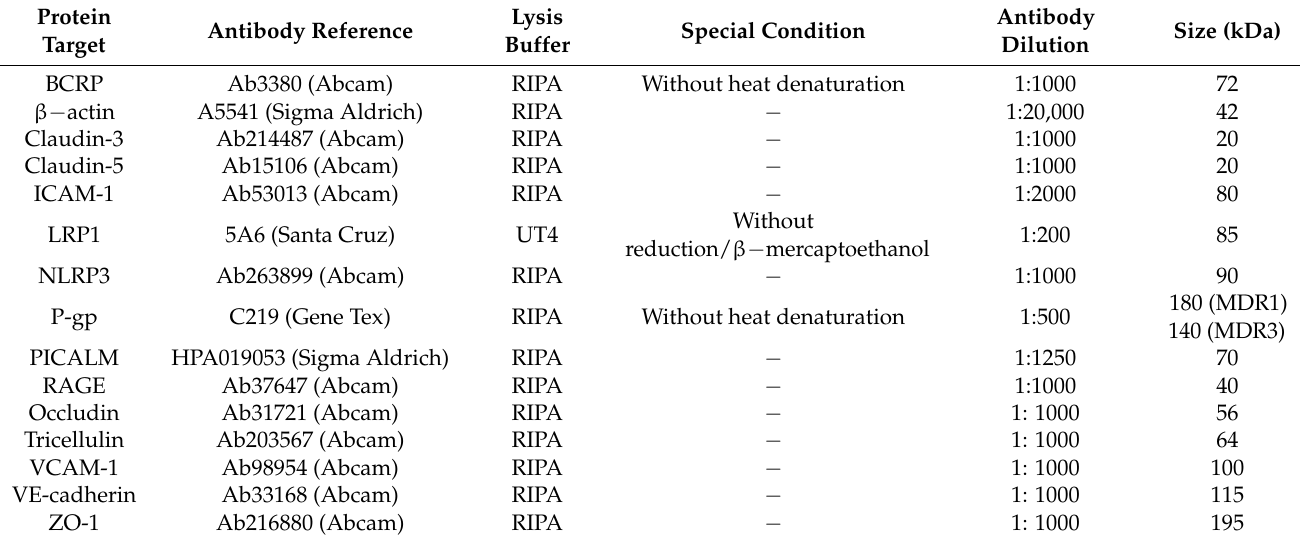
Table 3. Antibodies used for Western immunoblotting experiment. BCRP: breast cancer resistance protein; ICAM-1: intercellular adhesion molecule-1; LRP1: Low-density lipoprotein receptor-related protein 1; NLRP3: « NOD-like receptor family, pyrin domain containing 3; P-gp: permeability- glycoprotein; PICALM: phosphatidylinositol binding clathrin assembly protein; RAGE: receptor for advanced glycation endproducts; VCAM-1: vascular cell adhesion protein-1; VE-cadherin: